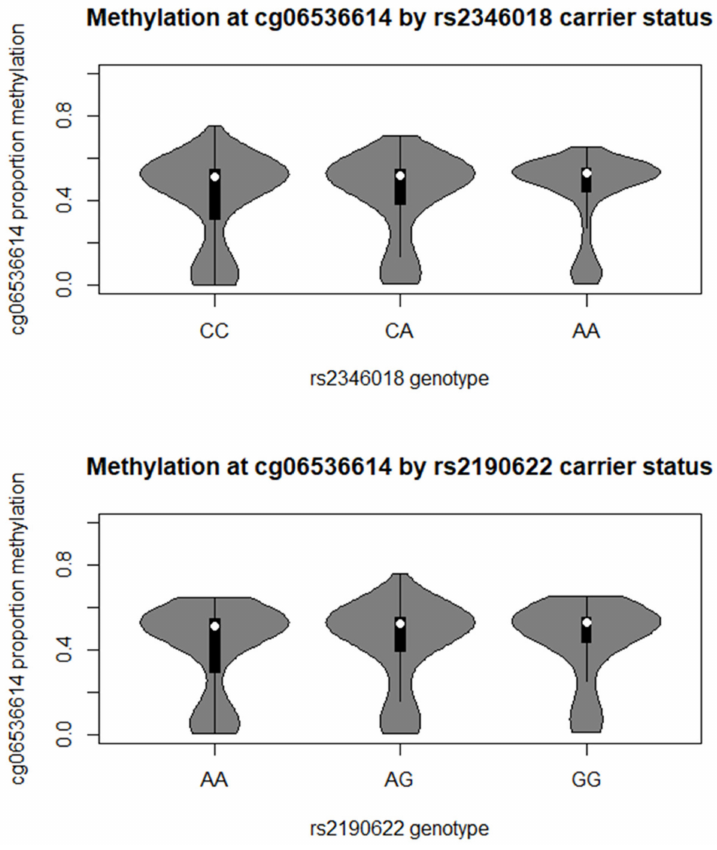
Figure 2. VTRNA2-1 promoter percentage methylation distribution by carrier status at rs2346018 (CTCF binding site) and rs2190622 (strongest observed association). Carrier frequency (percentage): rs2346018 : CC: 1969 (44%); CA: 1936 (43%); AA: 495 (11%); rs2190622 : CC: 1838 (41%); CA: 2064 (46%); AA: 597